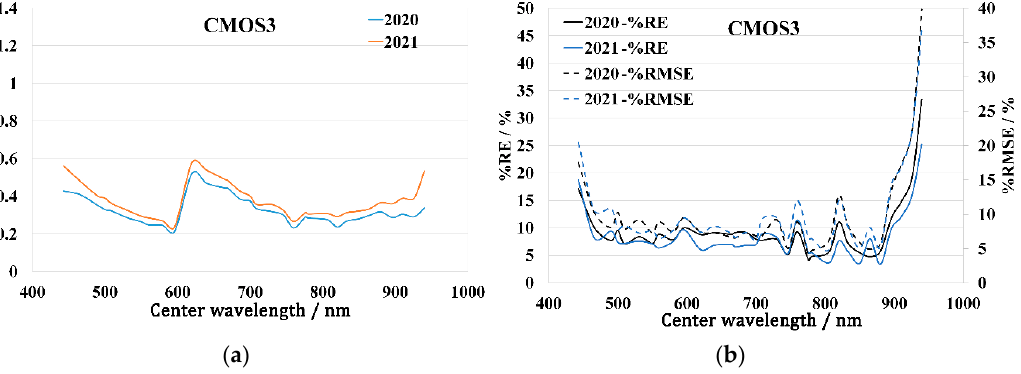
Figure 15. Comprehensive gain fitting results and fitting errors for OHS-F CMOS3. ( a ) Description of comprehensive gain fitting results; ( b ) description of comprehensive gain fitting error.